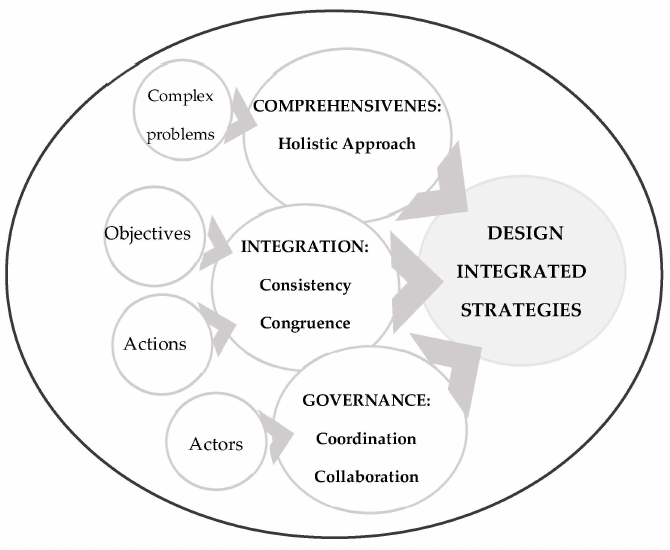
Figure 1. Dimensions of integrality in the design of integrated strategies. Source: elaborated by the authors.